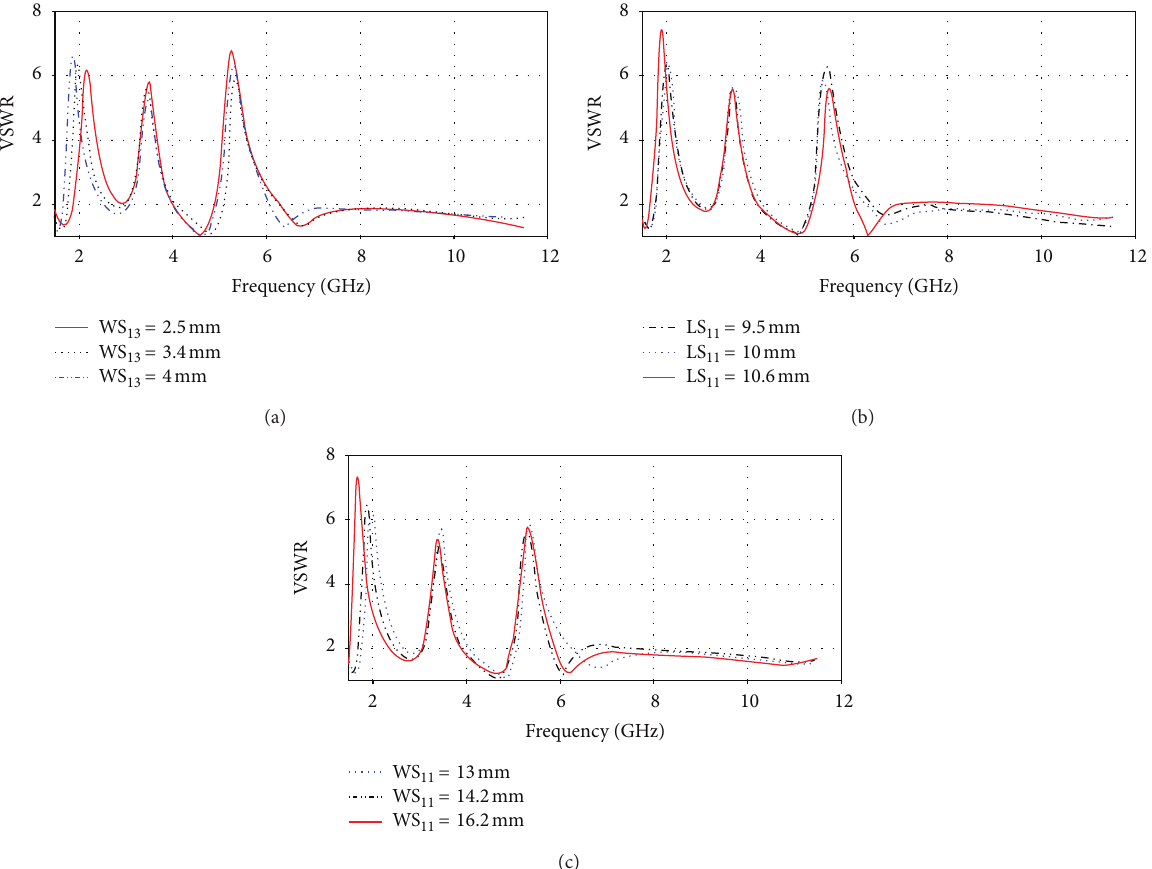
Figure 5: The simulated VSWR of the proposed antenna: effects of some parameters on the 2.2 GHz band-notched function, (a) WS 13 , (b) LS 11 , (c) WS 11